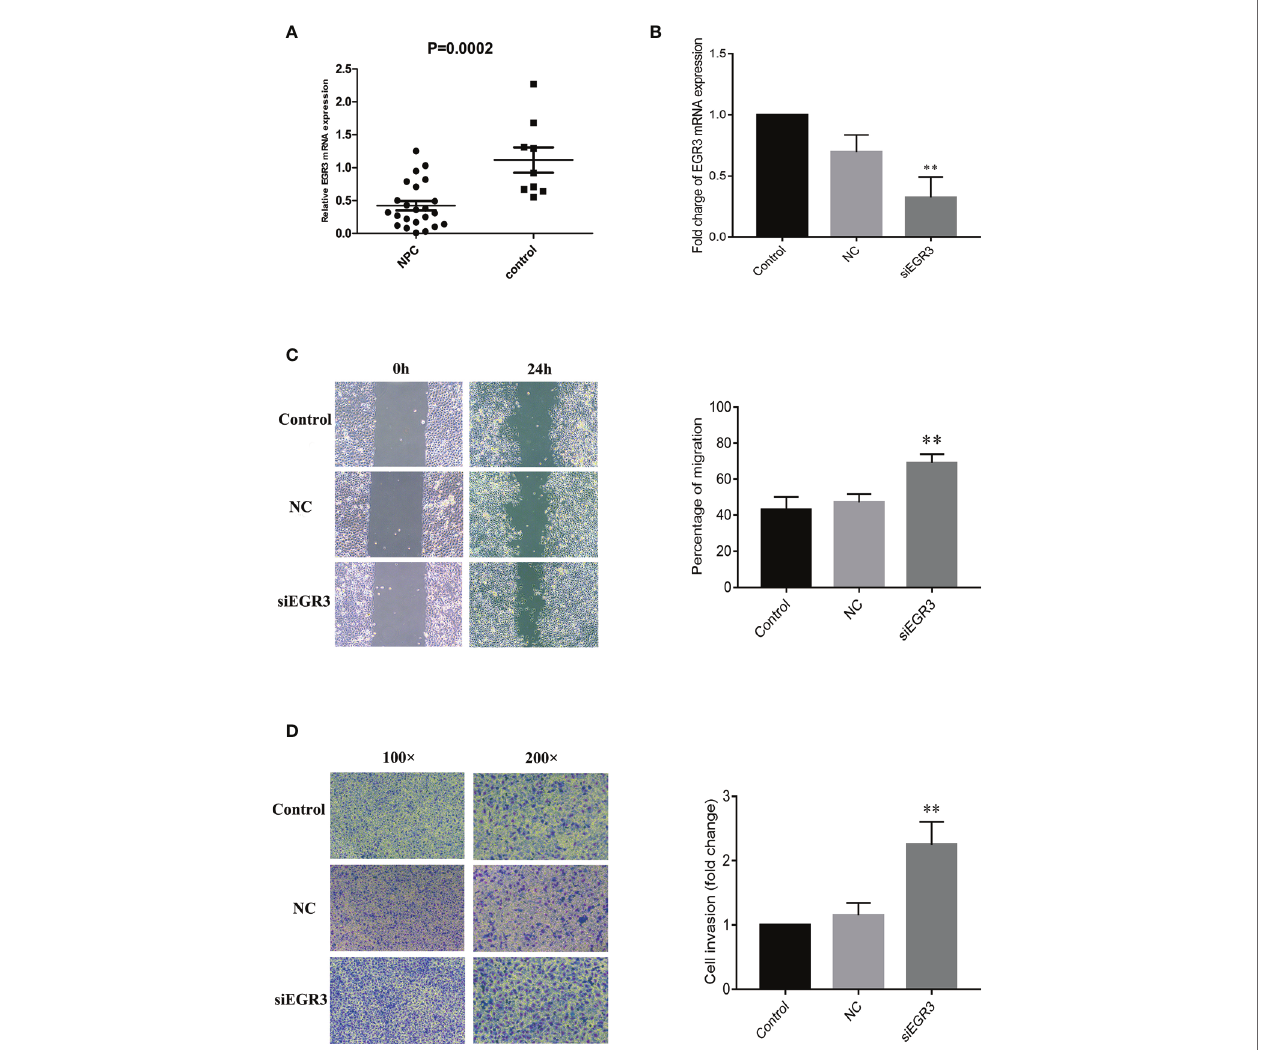
FIGURE 4 | EGR3 was decreased in nasopharyngeal carcinoma (NPC) clinical specimens, and its decrease could enhance NPC cell migration and invasion in vitro . (A) Relative expression of EGR3 mRNA by quantitative RT-PCR in NPC tissues compared with non-tumor tissues. (B) Relative expression of EGR3 mRNA by quantitative RT-PCR in 5-8F cells after transfection with siRNA. (C) Cell migration ability measured by the scratch wound healing assay. (D) Cell invasion ability measured by Boyden chamber assays with Matrigel. ** p <